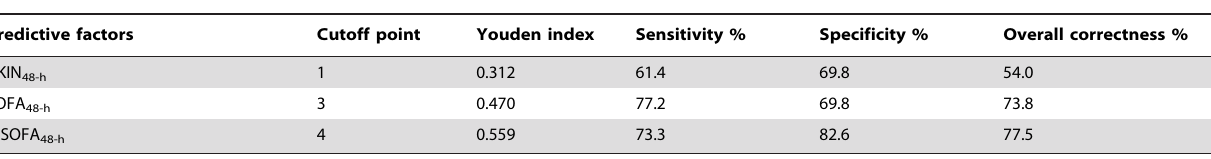
Table 7. Prediction of hospital mortality (n=